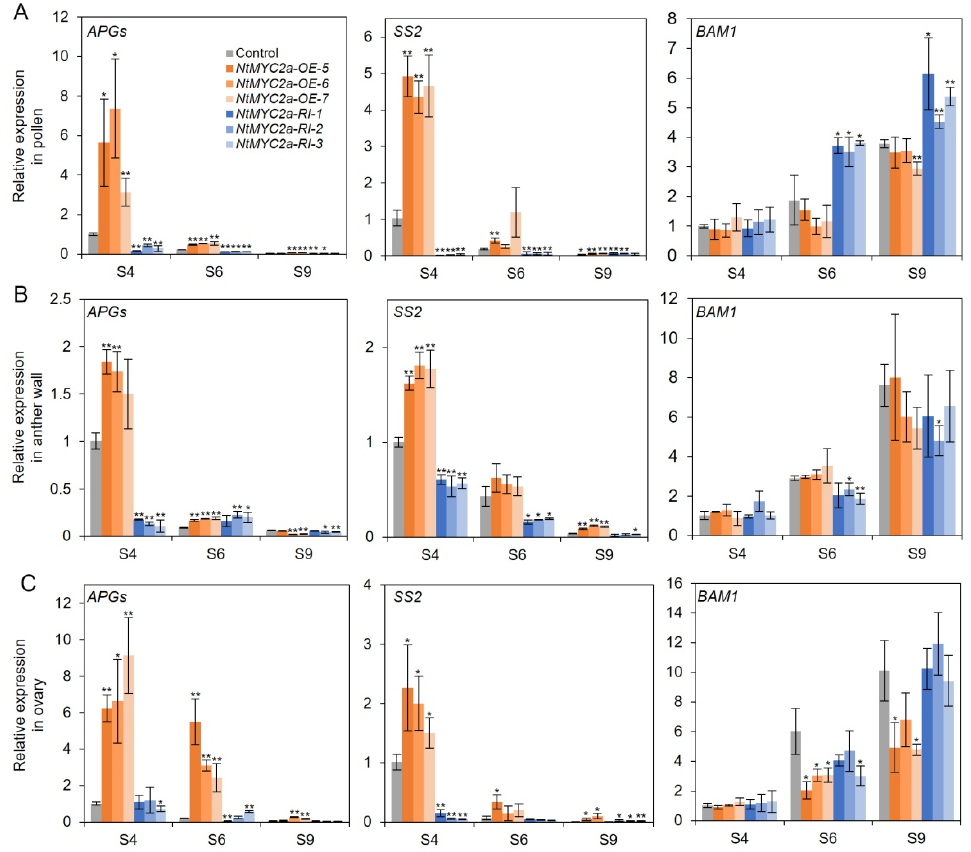
Figure 4. The transcriptions of AGPs, SS2 and BAM1 are regulated by NtMYC2a during flower development. Relative expression of AGPs, SS2 and BAM1 in pollen grains ( A ), anther walls ( B ) and ovaries ( C ) of NtMYC2a-OE , NtMYC2a-RI and control plants at S4, S6 and S9. For RT-qPCR assays, results are shown as means ± SD, n = 3. Significant differences from the data of control plant are indicated: * p < 0.05, ** p < 0.01 (Student’s t -test).